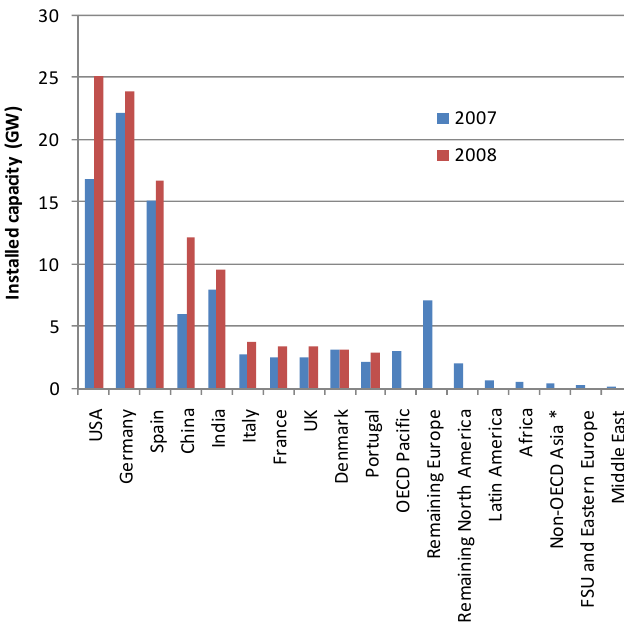
Figure 40. Installed wind power capacity by region (compiled from [51,196]). * Asia excludes China and India.